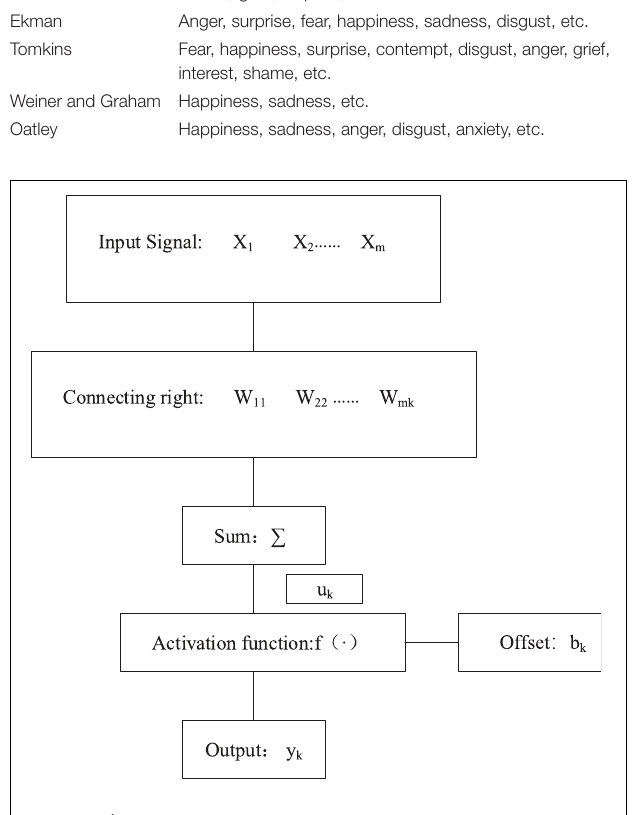
FIGURE 1 | Artificial neuron